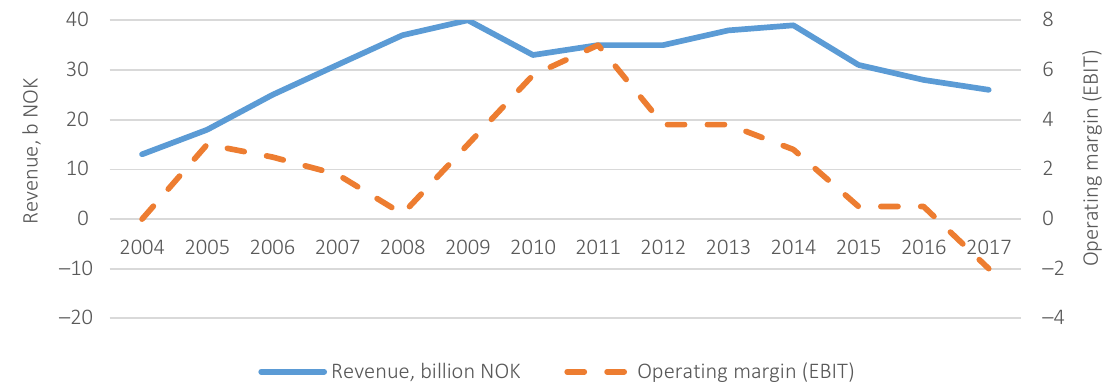
Figure 8. Turnover and operating margin among the shipyards